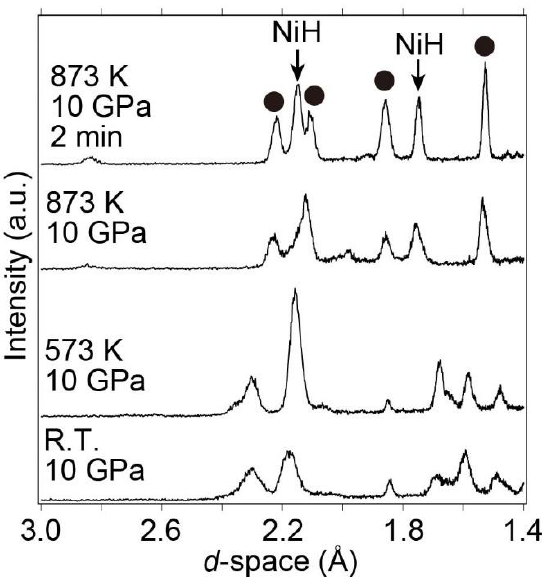
Figure 6. Synchrotron radiation X-ray diffraction patterns from room temperature to 873 K at 10 GPa. The Bragg peaks at 873 K and 10 GPa (2 min) are identified as NiH and a new phase with a hexagonal unit cell (closed circles).